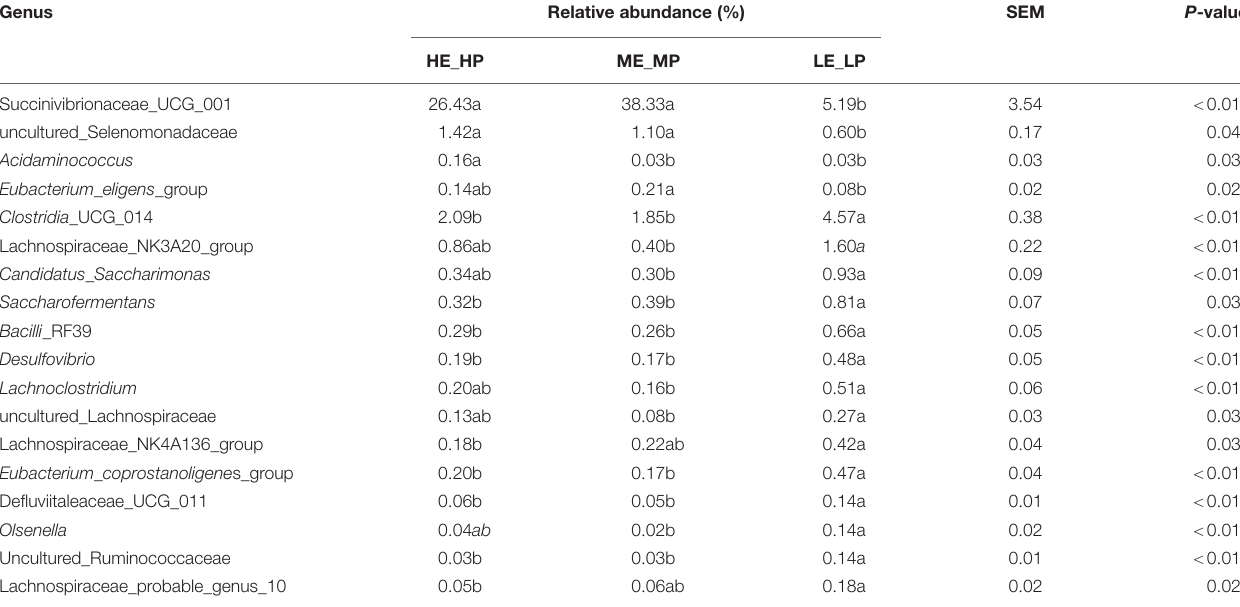
TABLE 2 | Relative abundances of specific bacteria in dairy cows with different nitrogen utilization efficiency. Genus Relative abundance (%) SEM P